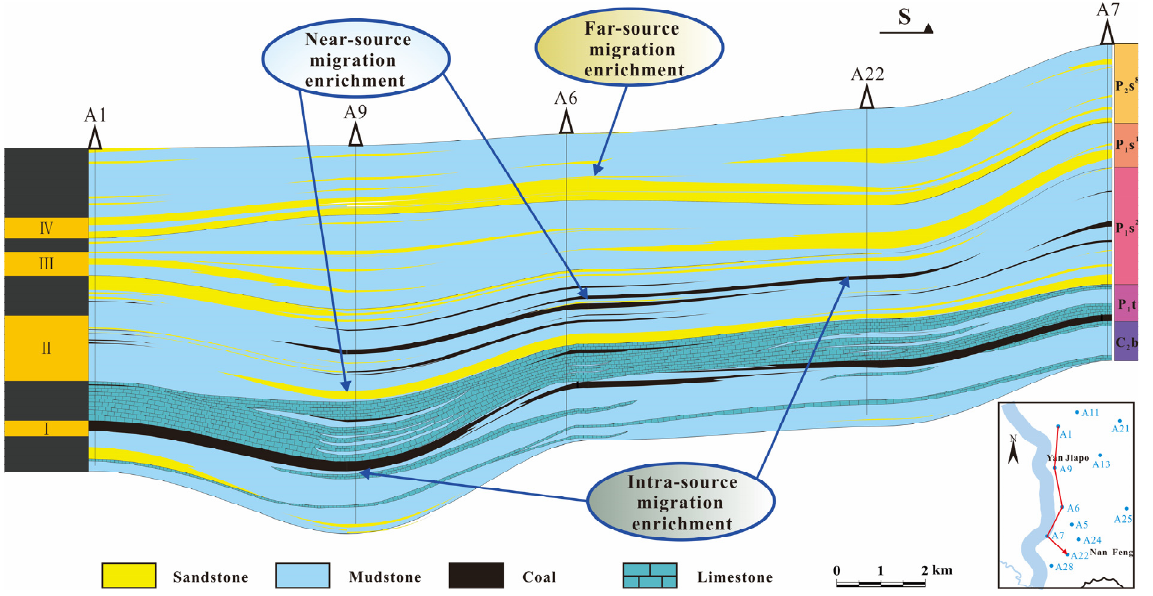
Figure 9. Connected well profile of coal measure enrichment type in the Daning–Jixian area .